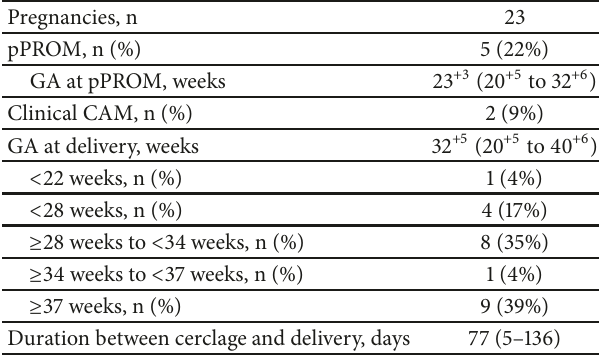
Table 3: Pregnancy and perinatal